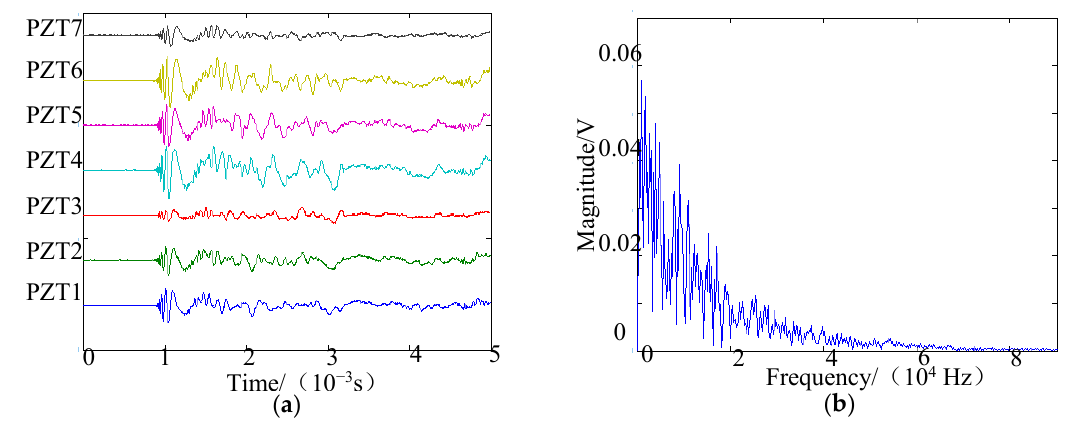
Figure 10. Sensor signals when impact occurred: ( a ) array-sensor signals; ( b ) frequency spectrum of impact signal obtained by PZT1.